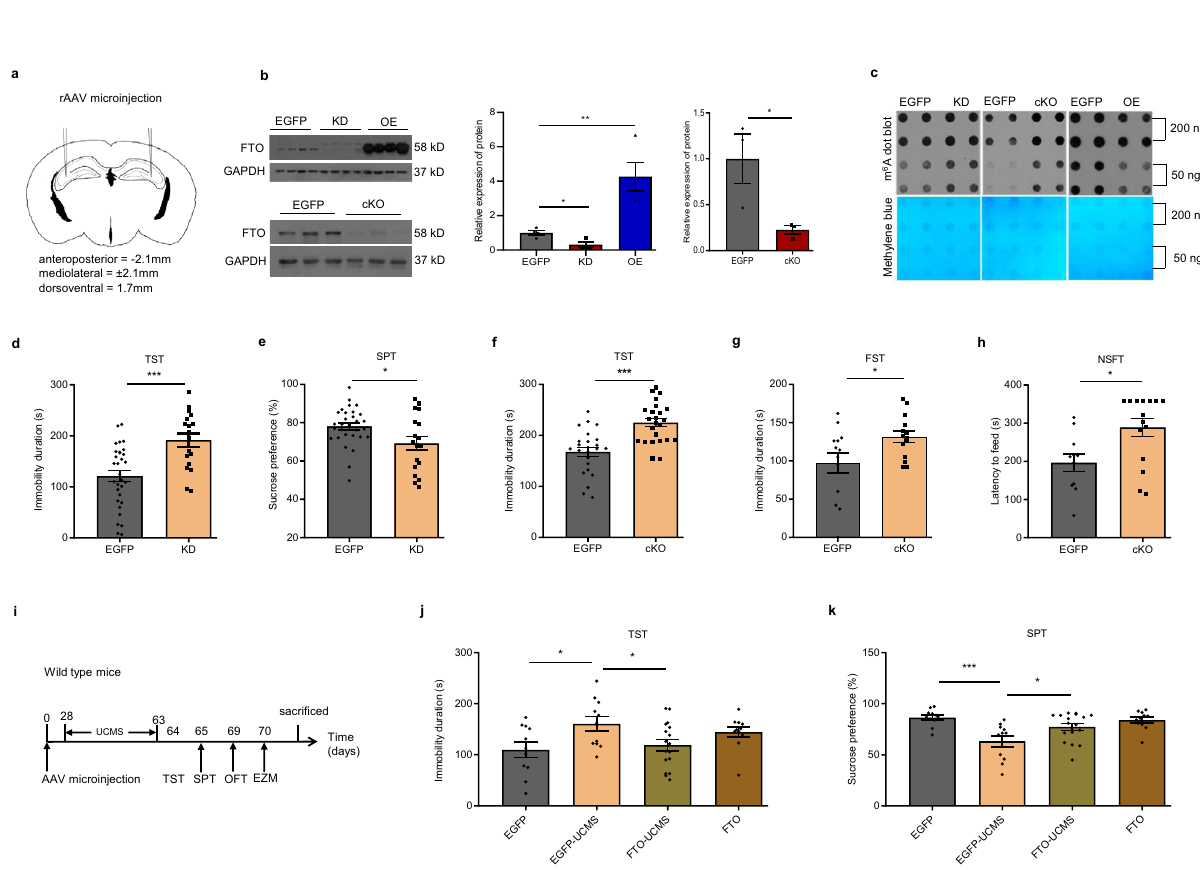
Fig. 2 FTO in the hippocampus mediates depression-like behaviors. a Schematic illustrations of rAAV microinjection. b Knockdown (KD), overexpression (OE), and knockout (cKO) of Fto in the hippocampus. EGFP, KD, OE, n = 4 per group; EGFP, cKO, n = 3 per group. EGFP vs. KD, p = 0.0124; EGFP vs. OE, p = 0.0082; EGFP vs. cKO, p = 0.0476. c m 6 A dot blot assay of hippocampal total RNA. d , e Tail suspension test (TST) and sucrose preference test (SPT) in KD mice. Ctrl, n = 31; KD, n = 18. d p = 0.0002; e p = 0.0469. f – h TST, FST, and novelty suppressed feeding test (NSFT) in three groups of cKO mice. f n = 24 per group, p < 0.0001; g EGFP, n = 13; cKO, n = 14; p = 0.0324. h EGFP, n = 11; cKO, n = 15, p = 0.0193. i Schematics of the experimental design. j , k TST and SPT in OE mice subjected to UCMS. EGFP, EGFP-UCMS, FTO, n = 11 per group; FTO-UCMS, n = 17. j EGFP vs. EGFP-UCMS, p = 0.0193; EGFP- UCMS vs. FTO-UCMS, p = 0.0367; k EGFP vs. EGFP-UCMS, p = 0.0003; EGFP-UCMS vs. FTO-UCMS, p = 0.0162. * p < 0.05, ** p < 0.01 *** p < 0.001. Two- tailed t -test for b and d – h ; one-way ANOVA analysis of variance for j & k . Adjustments were made for multiple comparisons test. Error bars represent s.e.m. Source data are provided as a Source Data fi ADRB2 is a target gene of FTO in the hippocampus . Given that were hypermethylated in KD and cKO mice, respectively, while FTO is a well-characterized RNA demethylase, we analyzed there were 613 hypomethylated genes in OE mice (Fig. 4b). hypermethylated mRNAs in KD and cKO mice, and hypo- Finally, we identi fi ed 34 genes that were both hypermethylated in methylated mRNAs in OE mice (Fig. 4a). After mapping each KD and cKO mice and hypomethylated in OE mice (Fig. 4c; peak to the corresponding gene, we found that 382 and 661 genes Supplementary Table 3). Gene-speci fi c m 6 A qPCR analysis of